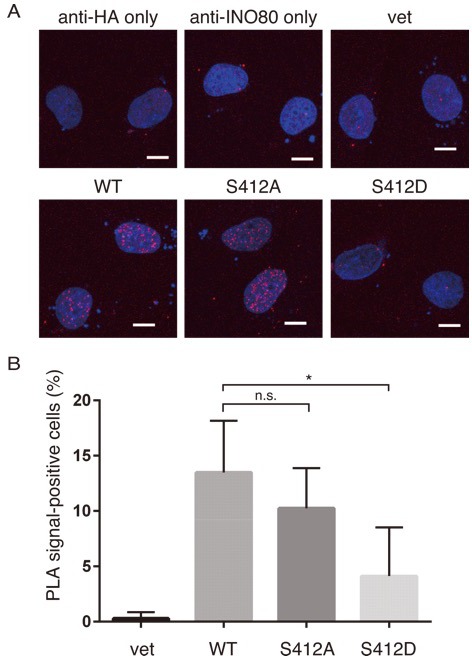
Examination of ARP8-INO80 interactions using Proximity ligation assay.(A) Proximity ligation assay (PLA) signals (in red) indicate ARP8-INO80 interactions. GM0637 cells were transfected with the HA-tagged wild-type, S412 A or S412D mutant of ARP8 or empty vector (vet). Nuclei were stained with DAPI (in blue). Scale bar: 10 μm. (B) Percentages of cells with more than five PLA signals. All results are the means of four independent experiments, and error bars show the standard deviation of the mean. *p<0.05. n.s.: no significant difference. Source data are presented in Figure 3—source data 3.